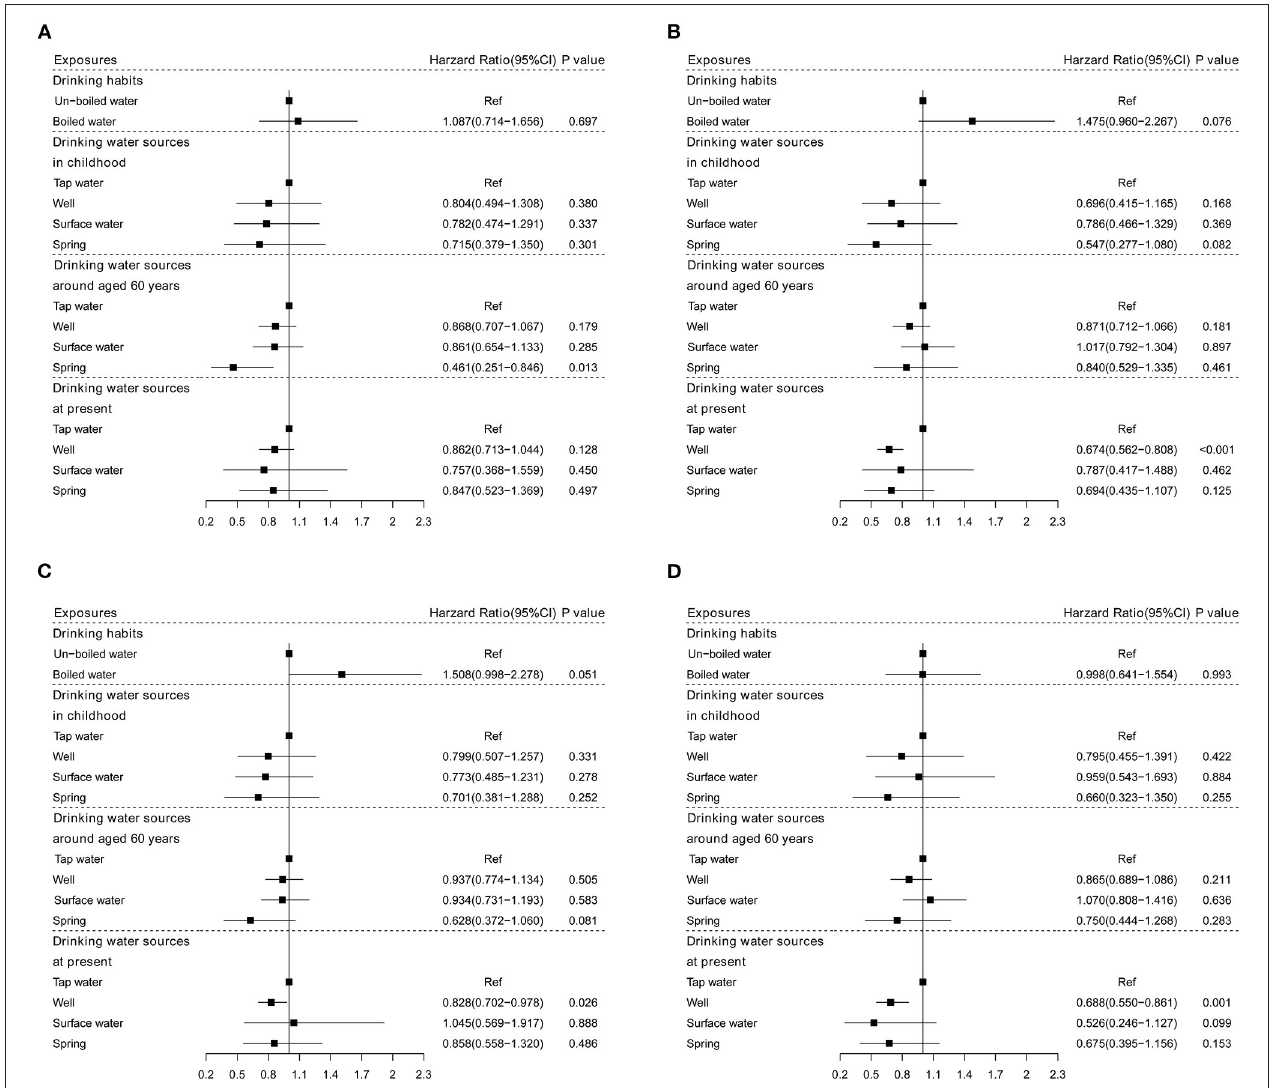
FIGURE 3 | The associations of drinking water sources and habits with CVD mortality stratified by sex and living areas. (A) Males; (B) females; (C) urban; and (D)